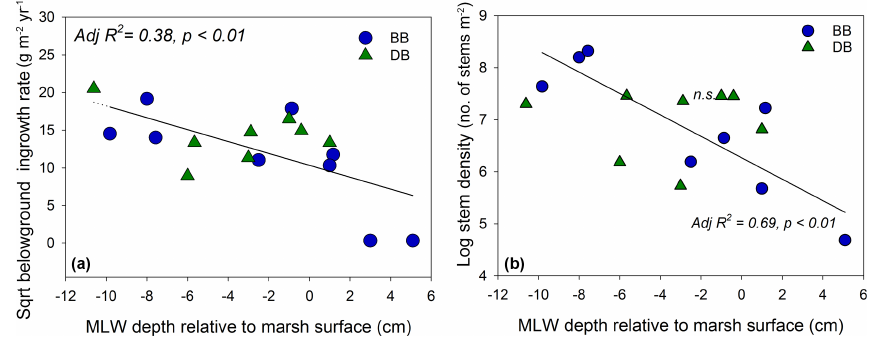
Figure 3. Relationships between belowground ingrowth and mean low water (MLW) relative to the marsh surface (a) and stem density and MLW (b) . Blue dots and green triangles refer to data collected in Barnegat Bay (BB) and Delaware Bay (DB), respectively. In Delaware Bay, the relationship between stem density and MLW was not